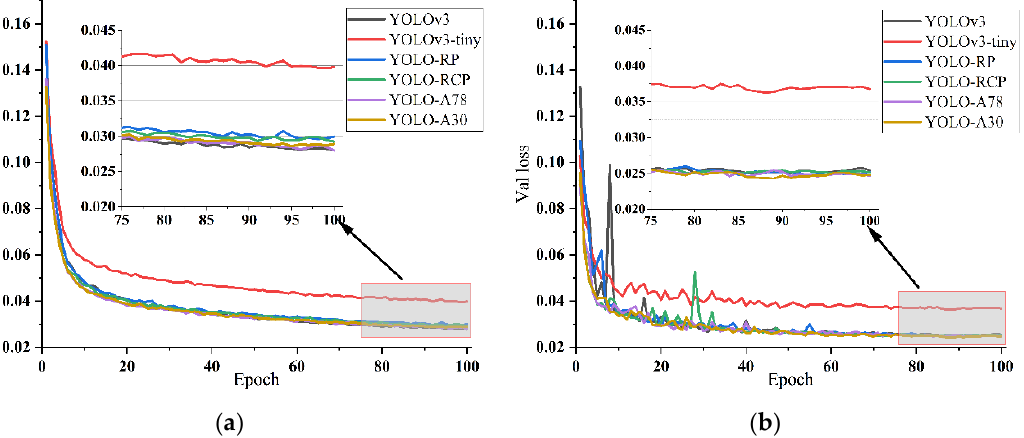
Figure 8. Training loss and validation loss of different models: ( a ) Training loss of six experimental models; ( b ) Validation loss of six experimental models.